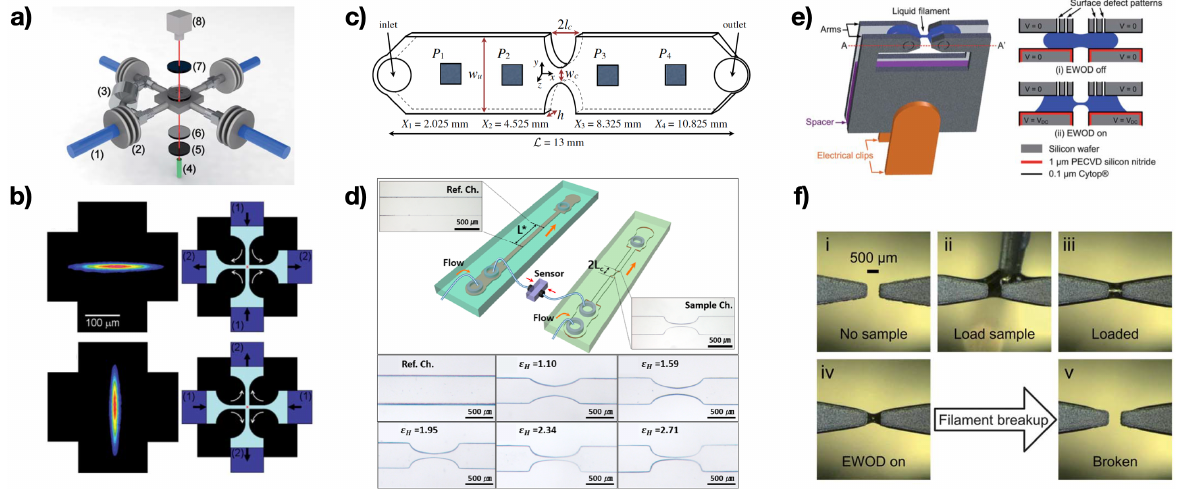
Figure 5. Examples of extensional microfluidic rheometers. ( a ) Schematic of the cross-slot microfluidic device, with two inlets and two outlets. ( b ) Flow birefringence measurements of polystyrene in dioctyl phthalate solutions. Different flow conditions are represented. Reprinted with permission from Reference [69], with permission of The Royal Society of Chemistry. ( c ) Schematic of the hyperbolic- contraction extensional rheometer. Reprinted with permission from Springer Nature, Rheologica Acta, Ober et al., Copyright (2013) [91]. ( d ) Schematic of the differential pressure extensional rheometer. The experimental snapshots represent different types of hyperbolic contractions channel compared to the straight reference channel. Reprinted with permission from Kim et al., Copyright (2018), The Society of Rheology [92]. ( e ) Schematic of the miniature capillary breakup extensional rheometer, where the liquid bridge is generated using electrowetting-on-dielectric actuation. ( f ) Experimental snapshots of the loading step for the device in ( e ). Reprinted with permission from Reference [93], with permission of The Royal Society of